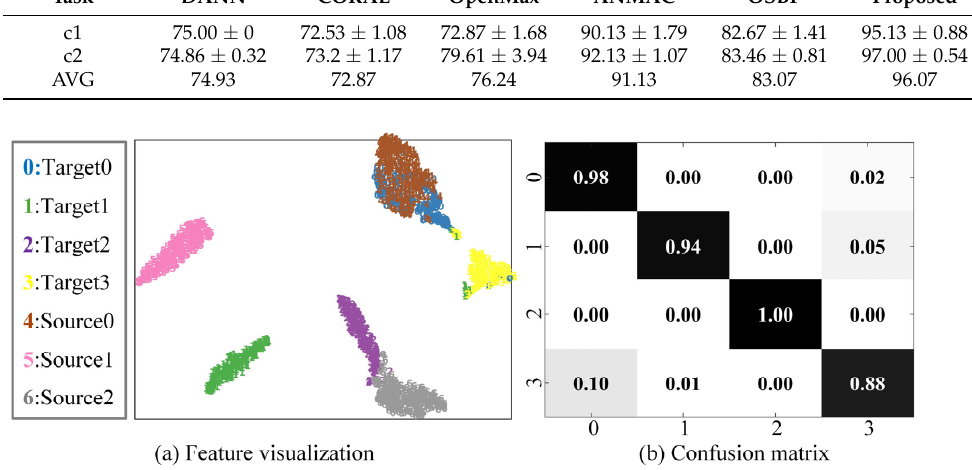
Figure 10. Results analysis of transfer task c1. ( a ) Feature visualization, ( b ) Confusion